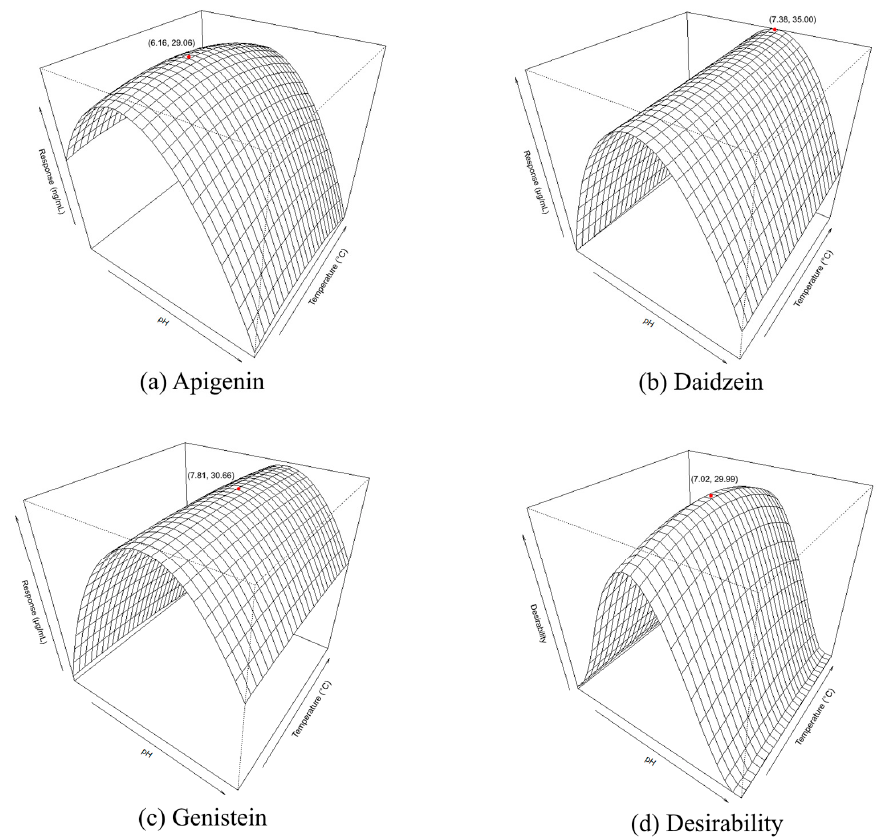
Figure 2. Response surface plots for the visualisation of interaction effects between pH and temperature (°C) on apigenin, daidzein, genistein and the desirability index for combined responses.